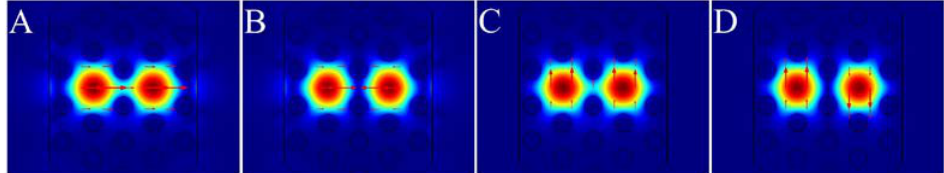
Figure 2. Electric field distributions of four fundamental supermodes at 1100 nm for the analyte refractive index ( n a ) of 1.44: ( A ) x -even mode; ( B ) x -odd mode; ( C ) y -even mode; ( D ) y -odd mode (the arrows represent the direction of the electric field).